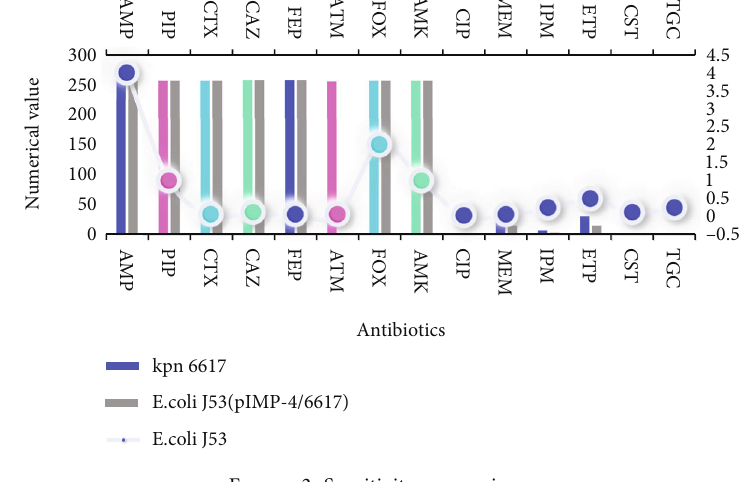
Figure 3: Sensitivity comparison.